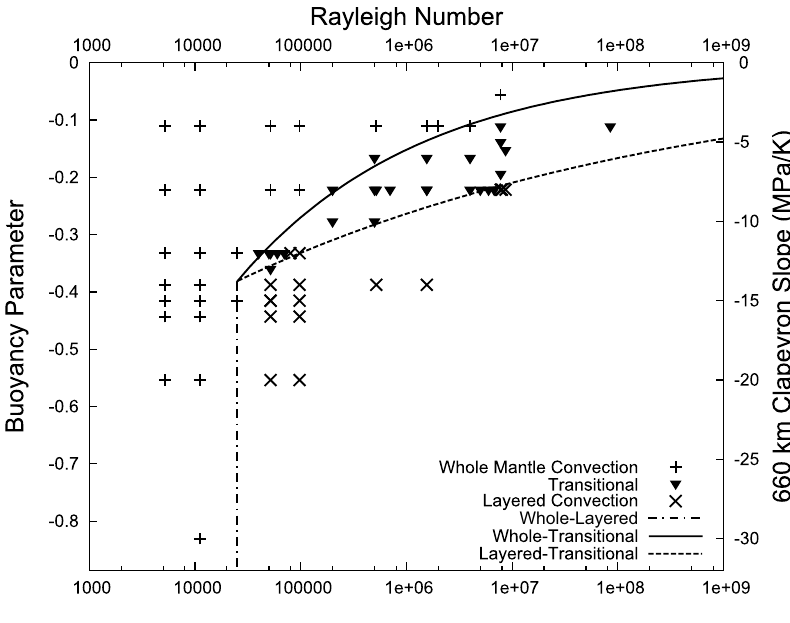
Fig. 3. Layering status of modelled cases as a function of convective vigour ( Ra ) and layering strength of the phase change (Buoyancy Parameter, P ). Key defines the symbols used to indicate the nature of the convection. The solid line is a power-law fit attempting to divide the whole and transitional cases, while the dashed line divides the layered and transitional cases. The vertical dash-dot line represents the whole-layered boundary, which only occurs at very low Ra and very negative Clapeyron slope values. The equivalent Clapeyron slope for our parameters is shown on the right hand side vertical